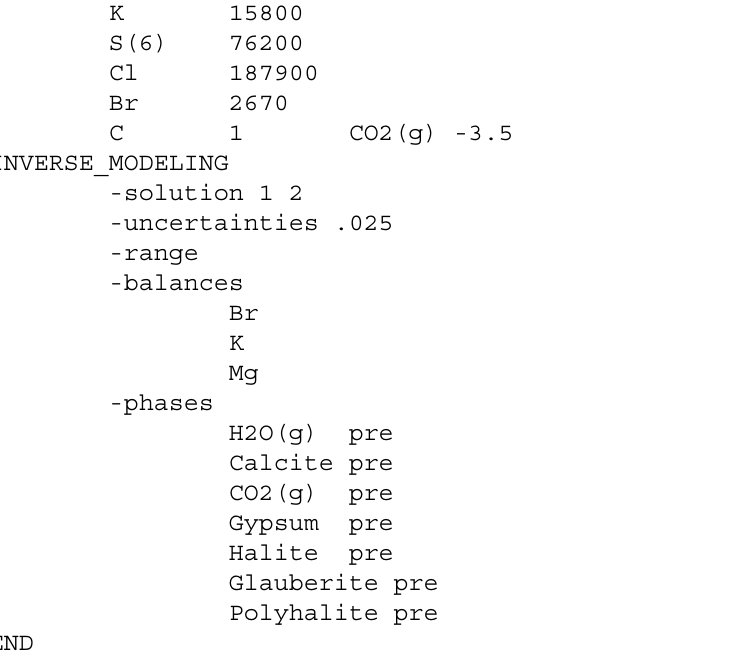
Table 49. Input file for example